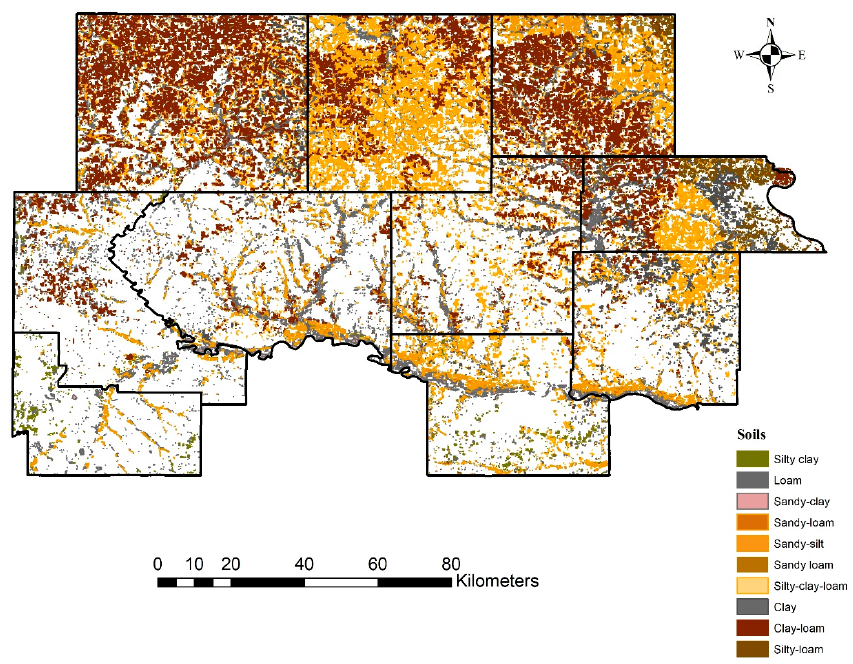
Figure 4. Spatially distributed gSSURGO soils in the study area. gSSURGO soils were classified based on the soil textural class.